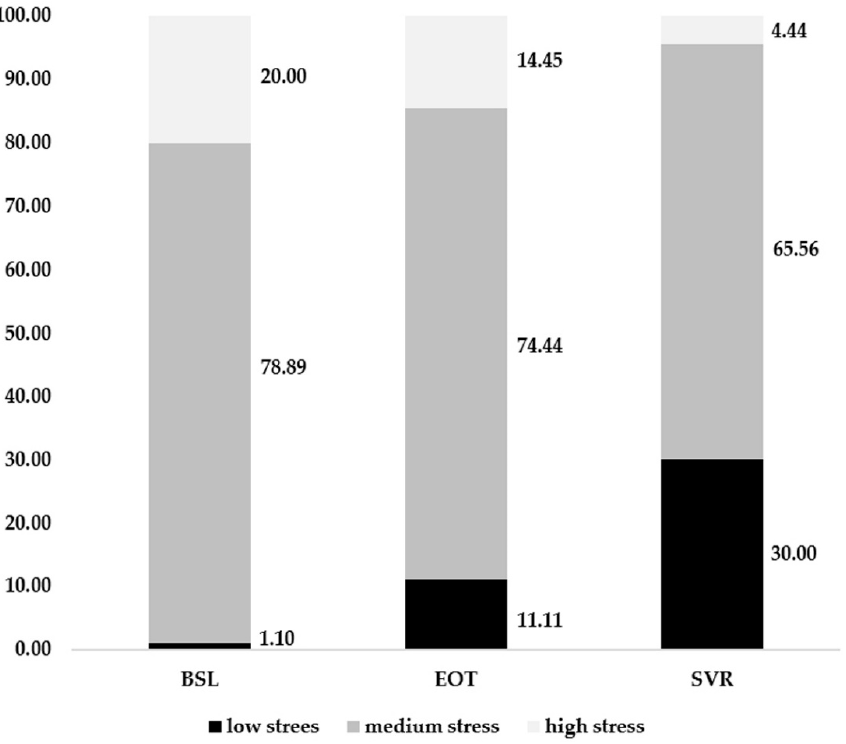
Figure 1. Evolution of PSS scores at BSL, EOT and SVR.